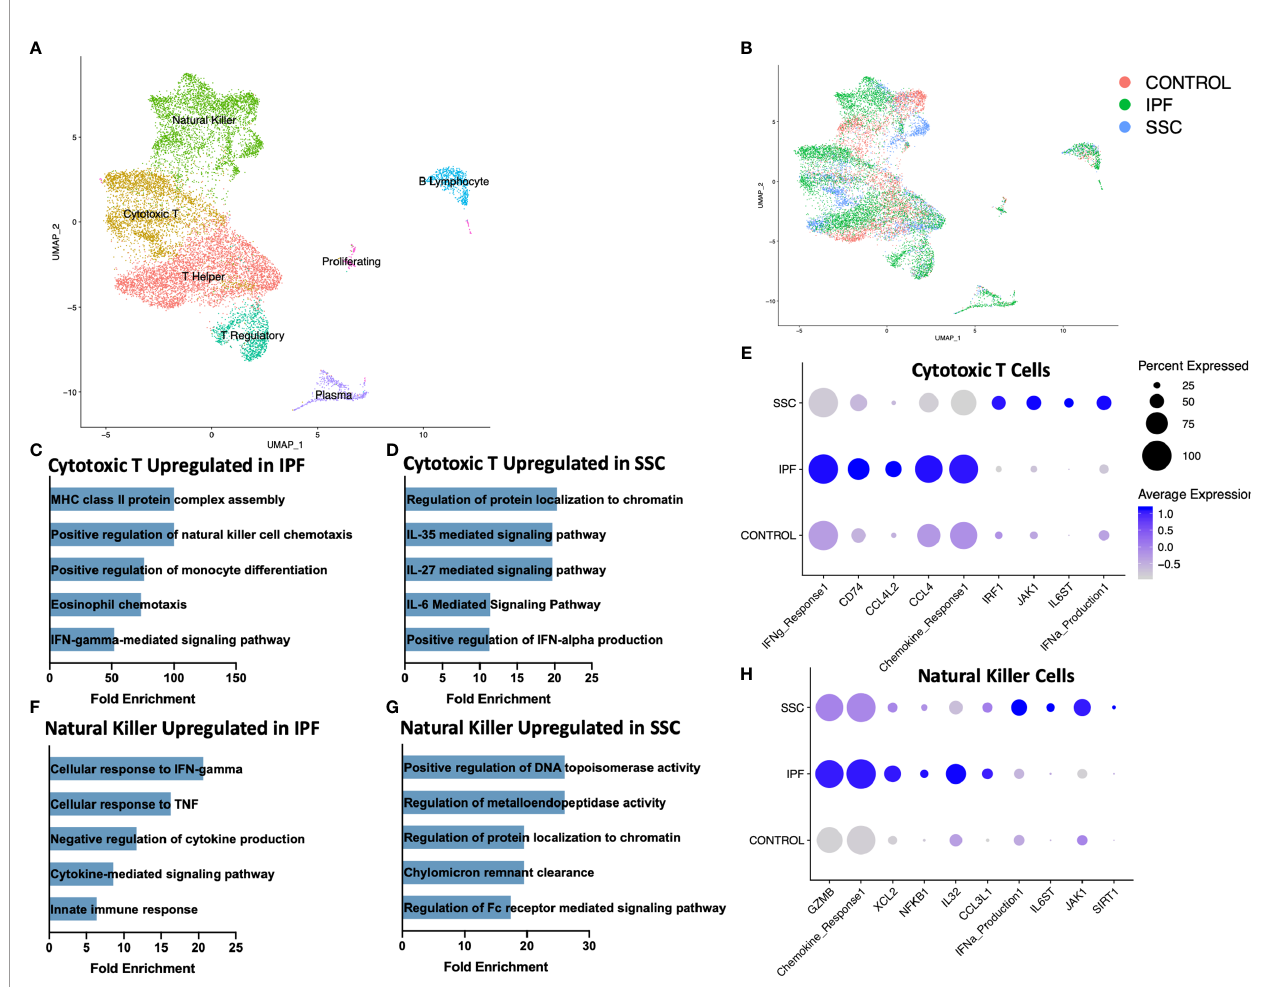
FIGURE 3 | ScRNA-seq analysis of IPF, SSc-ILD, and control lymphoid populations. (A) UMAP plot of lymphoid subpopulations, identi fi ed by cell type. (B) UMAP plot of lymphoid subpopulations, identi fi ed by disease status. (C) Pathways upregulated in IPF cytotoxic T cells compared to SSc-ILD cytotoxic T cells. If fold enrichment was calculated as >100 it is depicted as 100 for visualization. (D) Pathways upregulated in SSc-ILD cytotoxic T cells compared to IPF cytotoxic T cells (E) Expression of selected genes and pathways in cytotoxic T cells, separated by disease state. Pathway expression depicted as a module score of all genes in the speci fi c GO biological process. (F) Pathways upregulated in IPF NK cells compared to SSc-ILD NK cells (G) Pathways upregulated in SSc-ILD NK cells compared to IPF NK cells (H) Expression of selected genes and pathways in NK cells, separated by disease state. scRNA-seq, single-cell RNA-sequencing; IPF, idiopathic pulmonary fi brosis; SSc-ILD, systemic sclerosis-associated interstitial lung disease; UMAP, uniform manifold approximation and projection; NK, natural positive regulation of type I interferon production were upregulated in SSc-ILD cytotoxic T cells compared to IPF ( Figure 3D ). The proportion of natural killer cells trended toward a graded decline in fi brotic lower lobes compared to fi brotic upper lobes and controls, with a signi fi cant decline between controls and SSc-ILD lower lobes (p=0.0379). Cellular response pathways to IFN- g and TNF, and chemokine response were upregulated in IPF compared to SSc-ILD natural killer cells ( Figures 3F, H ); whereas regulation of metalloendopeptidase activity, and positive regulation of type I interferon production were upregulated in SSc-ILD compared to IPF natural killer cells ( Figures 3G, H , Supplemental File 3 ).